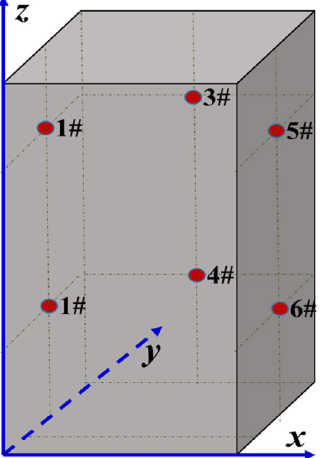
Figure 12. Schematic diagram of AE monitoring points layout for moment tensor inversion.